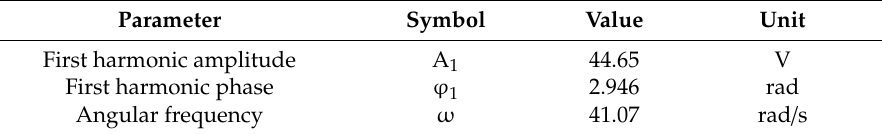
Table 3. Fourier approximation of no-load voltages produced by prototype.